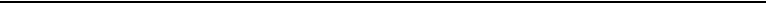
Fig. 2 Morgana silencing in TNBC cells reduces MMP9 expression. a , b Extracellular a and intracellular b MMP9 activity in MDA-MB-231 infected with an empty vector (EMPTY) or shRNAs targeting Morgana (shMORG1 and shMORG2) was evaluated by gelatin zymography. Top panel: representative zymogram of MMP9 activity (92 kDa). Bottom panel: quanti fi cation of MMP9 activity from 3 independent experiments. c Western blot analysis of conditioned medium (C.M.) obtained from MDA-MB-231 EMPTY or shMORG1 immunostained with MMP9, MMP2, Morgana and extracellular HSP90 as loading control. Morgana, as other chaperone proteins, can be secreted by cancer cells. d Western blot analysis of total protein extracts (T.E.) from MDA- MB-231 EMPTY and shMORG1 immunostained for MMP9, MMP2, Morgana and Vinculin as loading control. e , f Gene expression analysis by Real-time PCR of MMP9, MMP2 and CHORDC1 (Morgana coding gene) in MDA-MB-231 e and BT549 f EMPTY or shMORG1 and shMORG2. g , h Gene expression analysis by Real-time PCR of MMP9, MMP2 and CHORDC1 (Morgana coding gene) in MCF10A g and MCF7 h overexpressing Morgana (MORGANA) or control cells (EMPTY). i Quanti fi cation of invasion assays performed on MDA-MB-231 EMPTY or shMORG1 and shMORG2 infected or not with a lentiviral vector coding for MMP9 (shMORG1 MMP9, shMORG2 MMP9) or a shRNA targeting MMP9 (shMMP9). j Quanti fi cation of invasion assays performed on BT549 EMPTY or shMORG1 and shMORG2 infected or not with a lentiviral vector coding for MMP9 (shMORG1 MMP9, shMORG2 MMP9). Data are the results of at least three independent experiments. Bars in graphs represent standard errors (** p < 0.01; *** p <